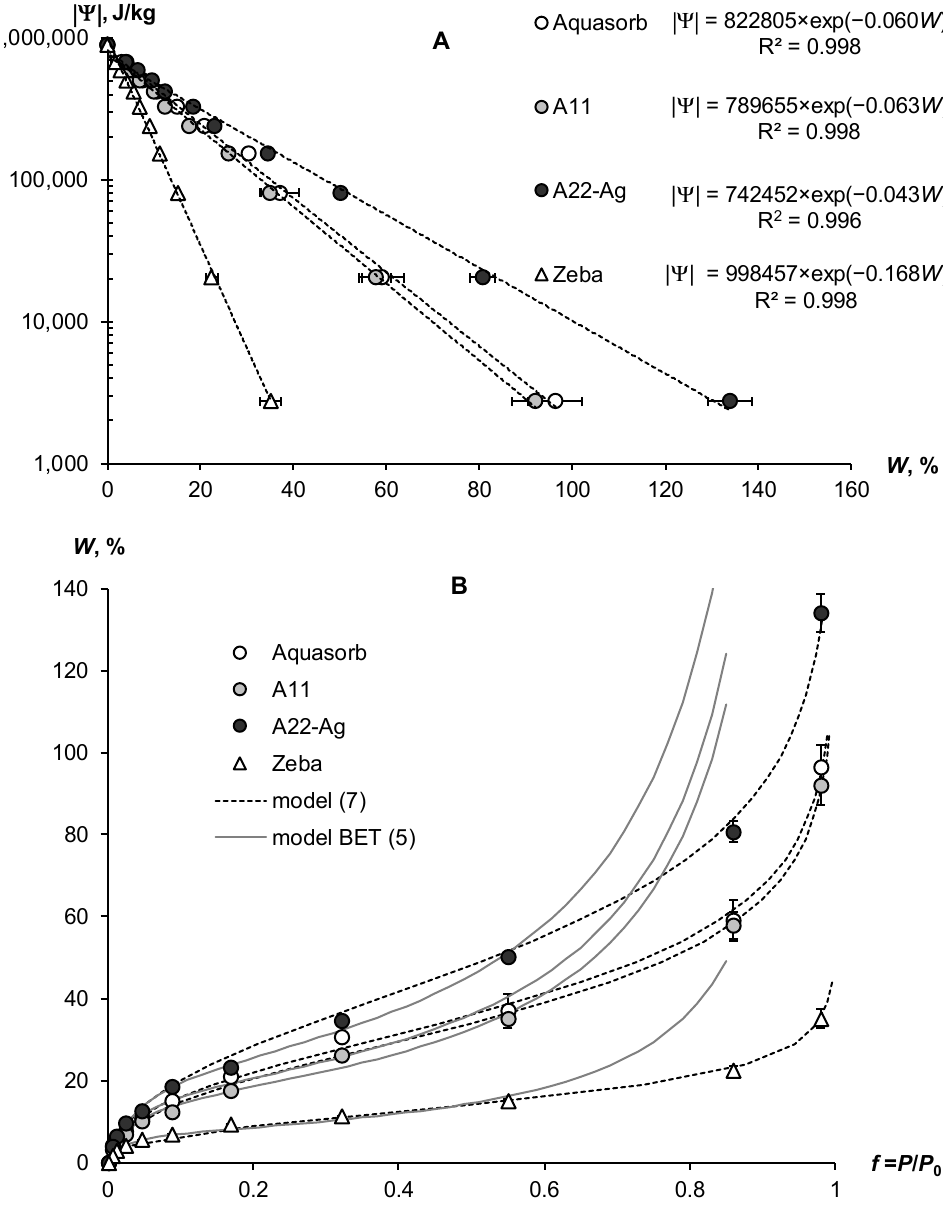
Figure 2. Experimental dependences of the thermodynamic potential and water content ( A ) and calculated water vapor desorption isotherms ( B ). Approximations of the experimental data by the disjoining pressure model (7) and the standard BET model (5) are shown by black dotted and solid gray lines, respectively.